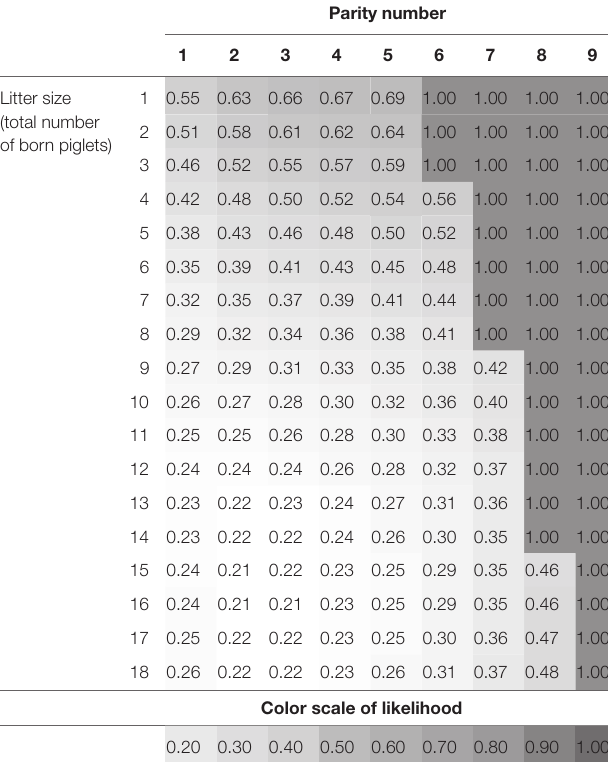
Table 4 | The likelihood of replacing a sow, by parity and litter size, as simulated by the dynamic programming model.